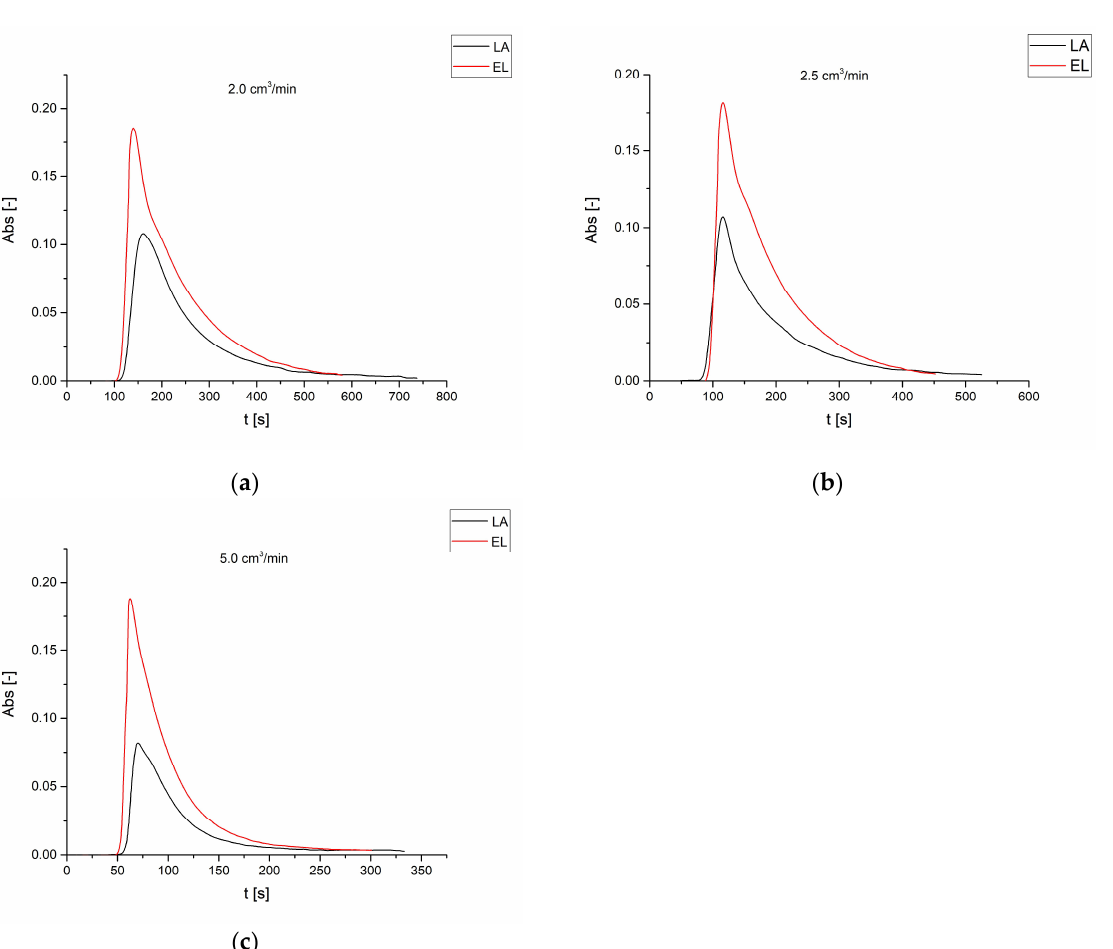
Figure 9. UV spectra of LA and EL 6 M at 323 K at different flow rates. ( a ) 2.0 cm 3 /min. ( b ) 2.5 cm 3 /min. ( c ) 5.0 cm 3 /min.